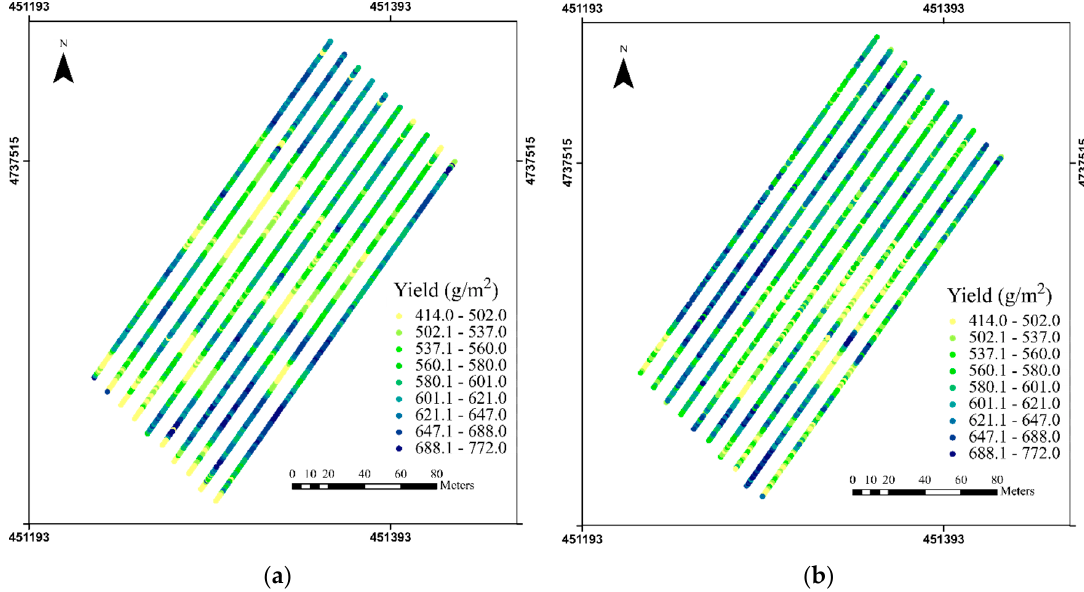
Figure 12. Comparison between the true grain yield generated from combine harvester and the estimated yield derived from SAFY model and UAV-based point cloud LAI data in S2 over 1828 points. ( a ) harvester measured grain yield map; ( b ) estimated yield map.